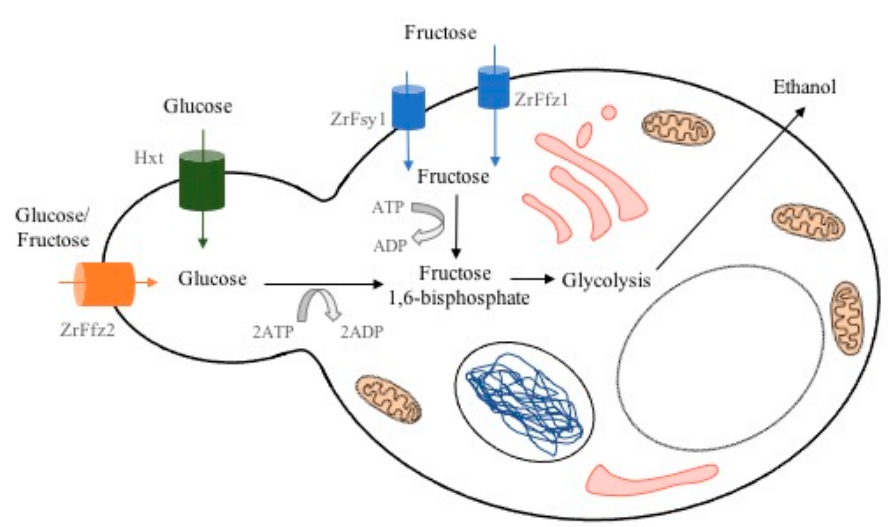
Figure 2. Fructose and glucose transporters during Z. rouxii ethanol fermentation.